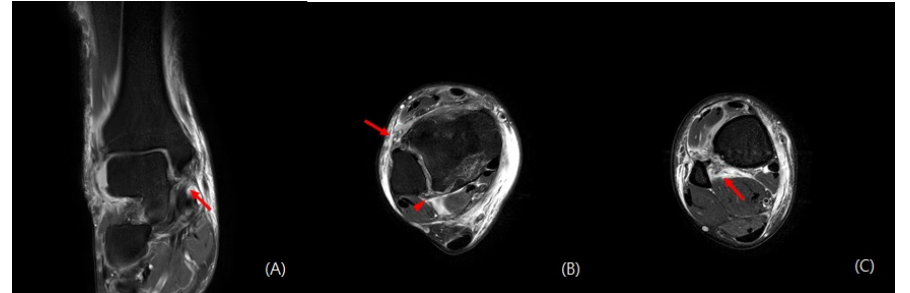
Figure 3. Coronal magnetic resonance imaging (MRI). An area of high signal intensity (red arrow) indicates a deltoid ligament injury ( A ). Axial MRI showing the anterior inferior tibiofibular ligament (red arrow) and posterior inferior tibiofibular ligament (red arrowhead) injuries ( B ). Axial MRI showing interosseous membrane rupture (red arrow) ( C ).